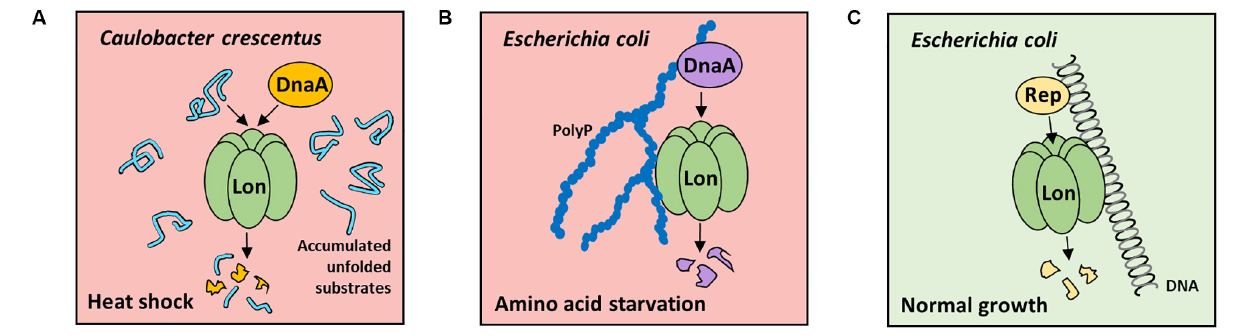
FIGURE 1 | Factors stimulating Lon-dependent proteolysis of replication initiators in Caulobacter crescentus and Escherichia coli during stress or normal growth conditions. (A) In C. crescentus in heat-shock conditions, unfolded substrate accumulation stimulate Lon protease for DnaA degradation, which results in inhibition of DNA replication initiation. (B) In E. coli cells during amino acid starvation, PolyP-induced DnaA proteolysis (PDAP) is launched. PolyP activates Lon protease to degrade DnaA, thereby resulting in the decreasing DnaA level and, consequently, DNA replication initiation arrest. (C) Under normal growth conditions,